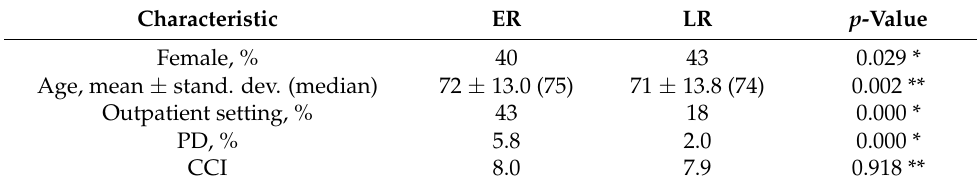
Table 1. Characteristics of HD and PD patients.